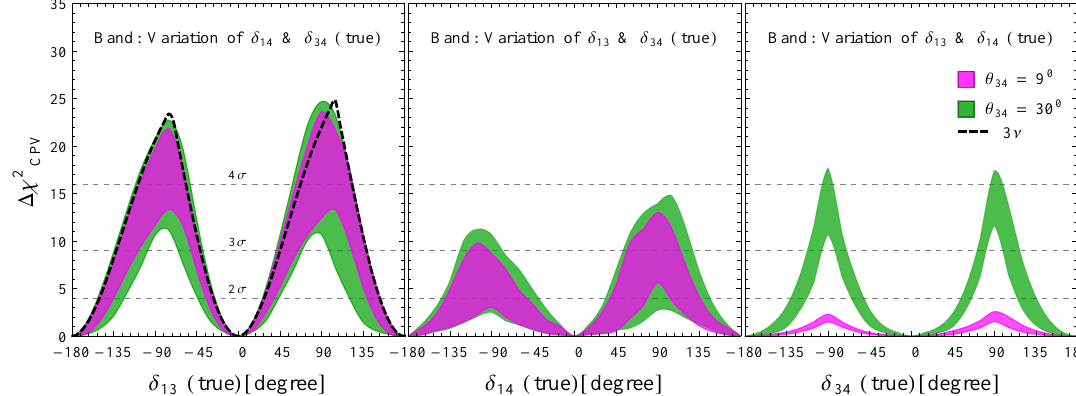
Figure 5. The left , central , and right panels display the discovery potential of the CPV induced, respectively, by δ 13 , δ 14 , and δ 34 in the 3 + 1 scenario. The thinner (magenta) bands correspond to the case in which the three new angles have the same value θ 14 = θ 24 = θ 34 = 9 ◦ . The thicker (green) bands correspond to the case in which θ 14 = θ 24 = 9 ◦ , and θ 34 = 30 ◦ . In each panel, the bands have been obtained by varying the true values of the two undisplayed CP-phases in the range [ − π , π ] . The left panel also reports the 3-flavor curve (black dashed line) for comparison. In all cases, we marginalize over hierarchy with NH taken as as the true choice. Figure taken from